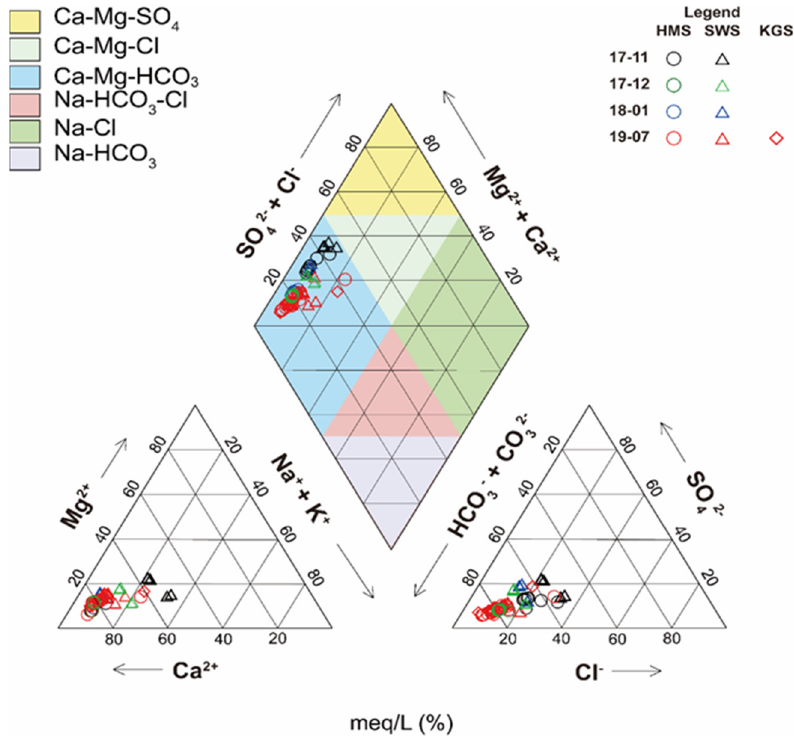
Figure 3. Piper diagram of surface water in Samcheok (black: Nov. 2017, green: Dec. 2017, blue: Jan. 2018, red: Jul. 2019).